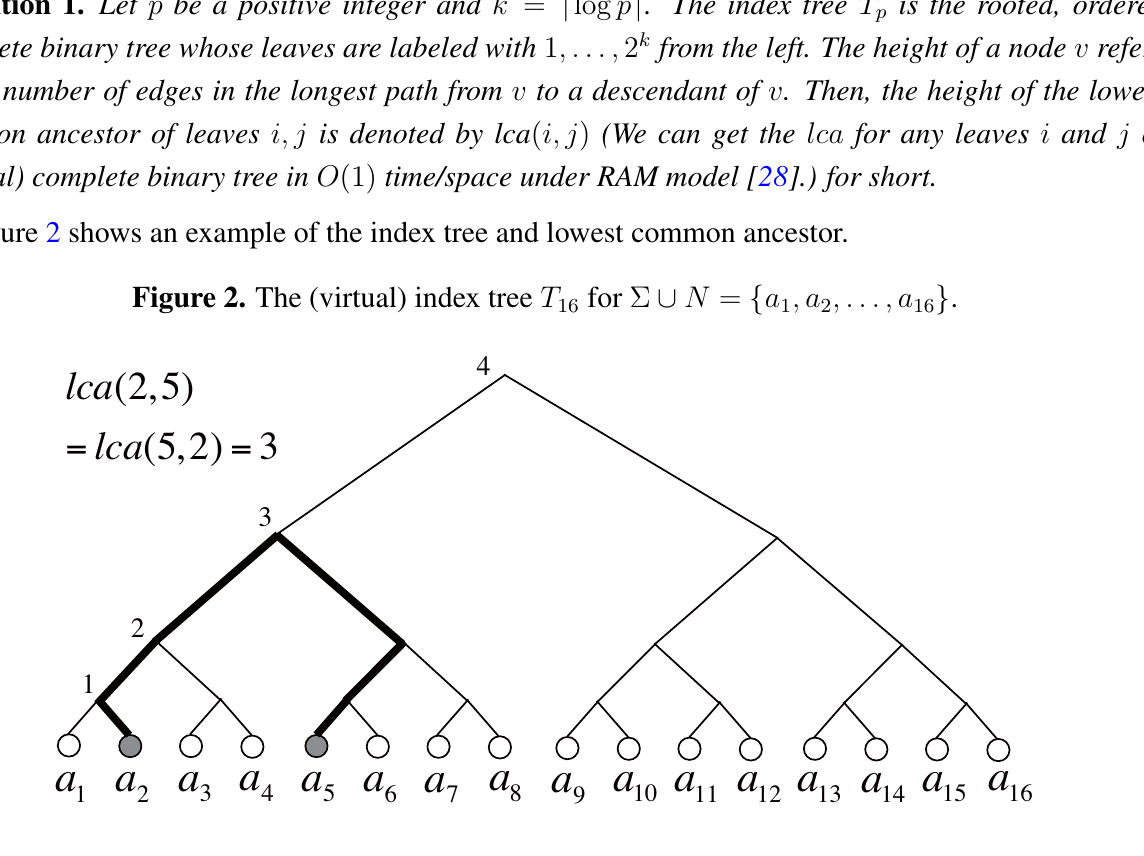
Figure 2. The (virtual) index tree T